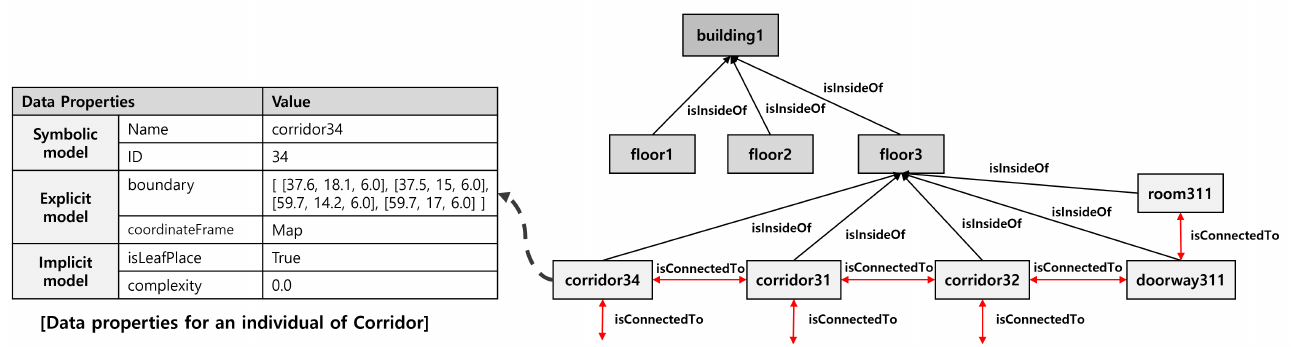
Figure 2. An example of place individuals’ asserted object and data